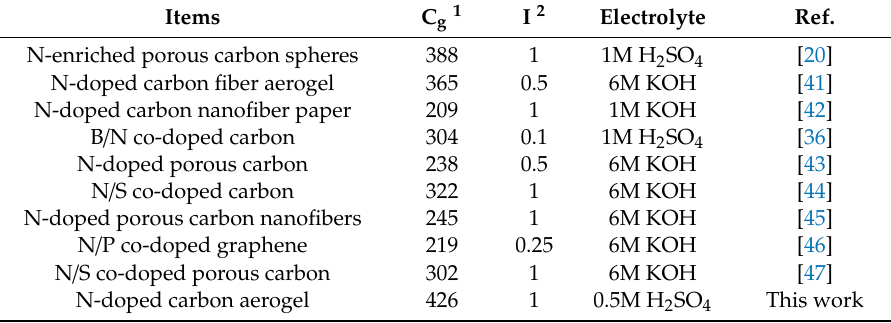
Figure 4. ( a ) CV curves of CA and N-CA at a scan rate of 10 mV·s − 1 ; ( b ) GCD curves of the N-CA at various current densities; ( c ) gravimetric capacitances of the N-CA and the CA at different current densities; and ( d ) cycling stability of the N-CA at 20 A·g − 1 , inset: CV curves of the N-CA electrode at the 1st (black) and the 10,000th cycle (red) at 10 mV·s − 1 , respectively. Table 2. C g of previously reported carbon-based electrode materials and the N-CA.